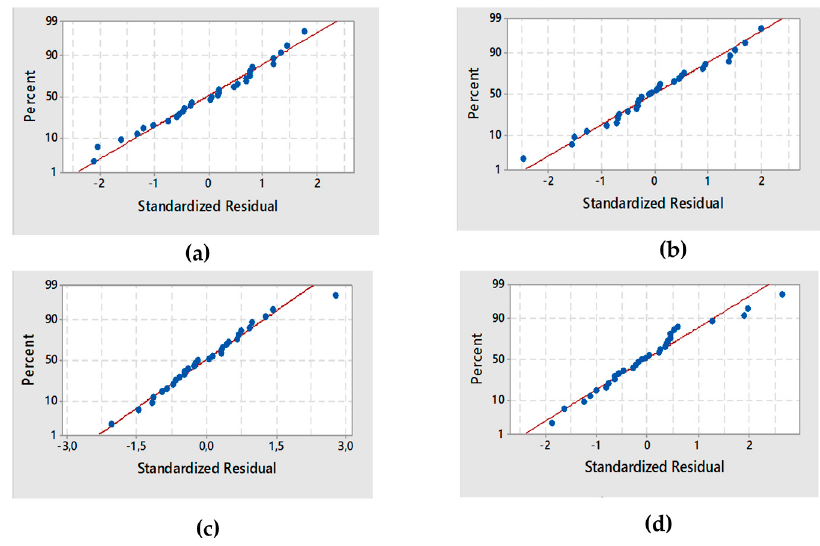
Figure 2. Normal probability plot for the four responses: ( a ) decolorization efficiency De, ( b ) L C1 , ( c ) L C2 , ( d ) L C3 .